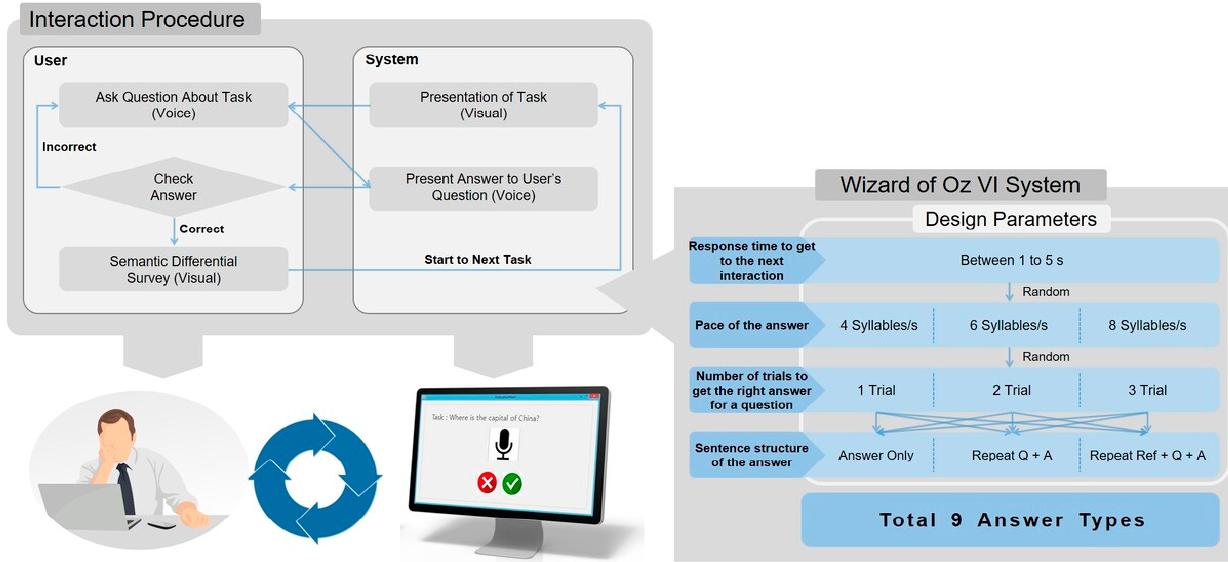
Figure 2. Voice-based intelligent system satisfaction evaluation